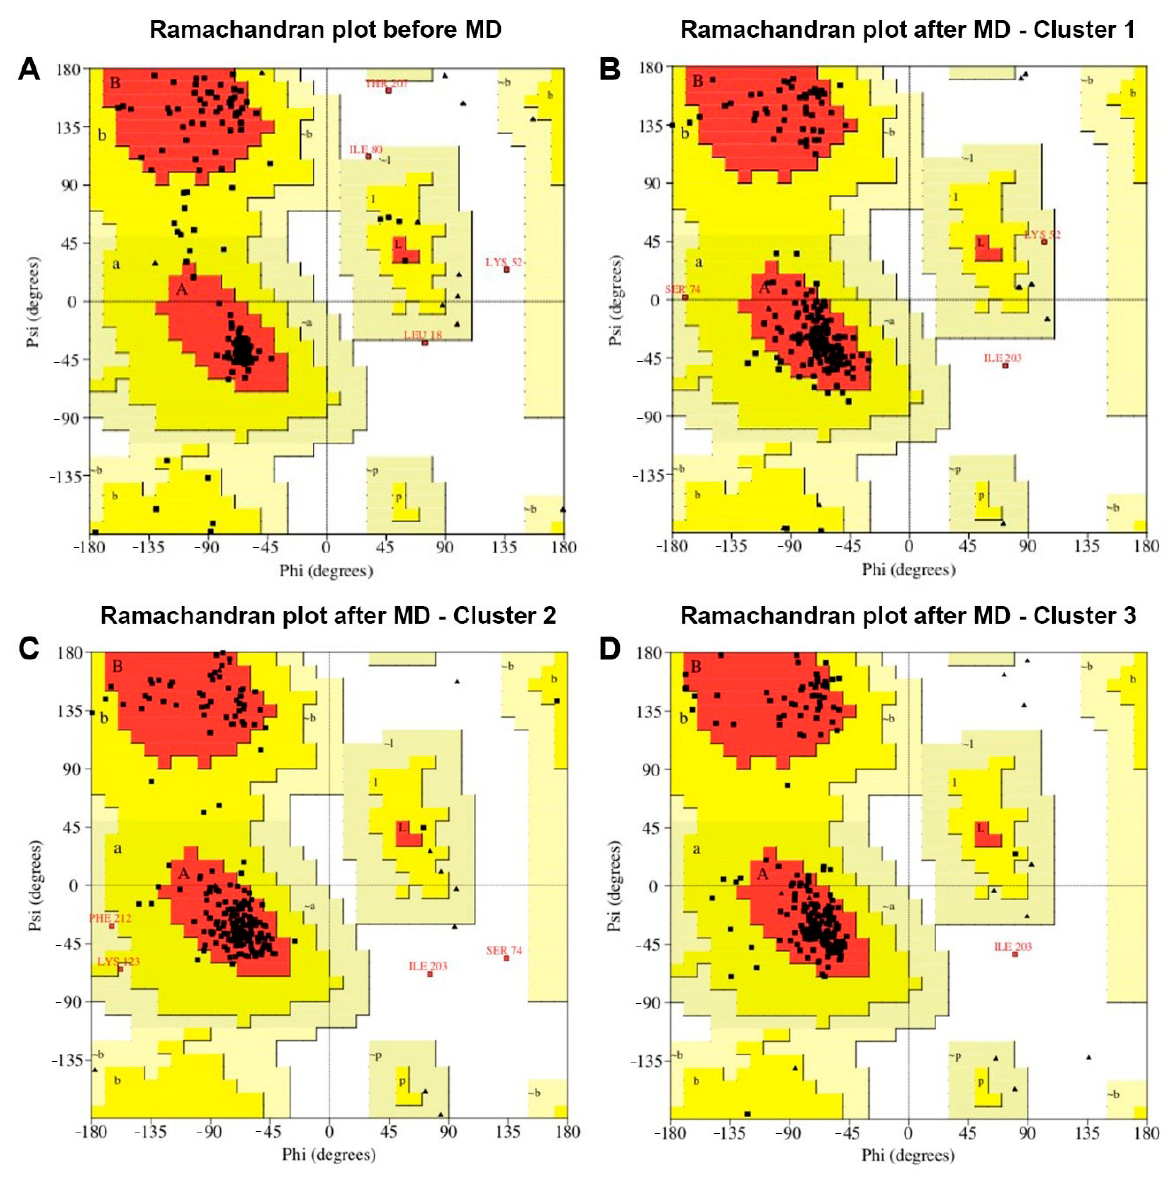
Figure 5. Structure quality assessment using ProCheck for the babaco mosaic virus coat protein with Ramachandran plot analysis. Square dots represent each residue. ( A ) Ramachandran plot of the structure before molecular dynamics refinement. Diagrams ( B – D ) show the Ramachandran plots for three different cluster representatives of the molecular dynamics refinement. Upper case letters (A, B, L, P) indicate most favored secondary structures, lower case indicate additional allowed regions (a, b, l, p). After molecular dynamics, most of the residues in the allowed regions move to the core region. The diagram also shows that most residues are in the alpha-helix region (the red region between the top and bottom left quadrants), and some at the beta-sheet region (top left quadrant). Table 2. Root mean square fluctuation of several babaco mosaic virus proteins from 50 ns produc- tion trajectory.